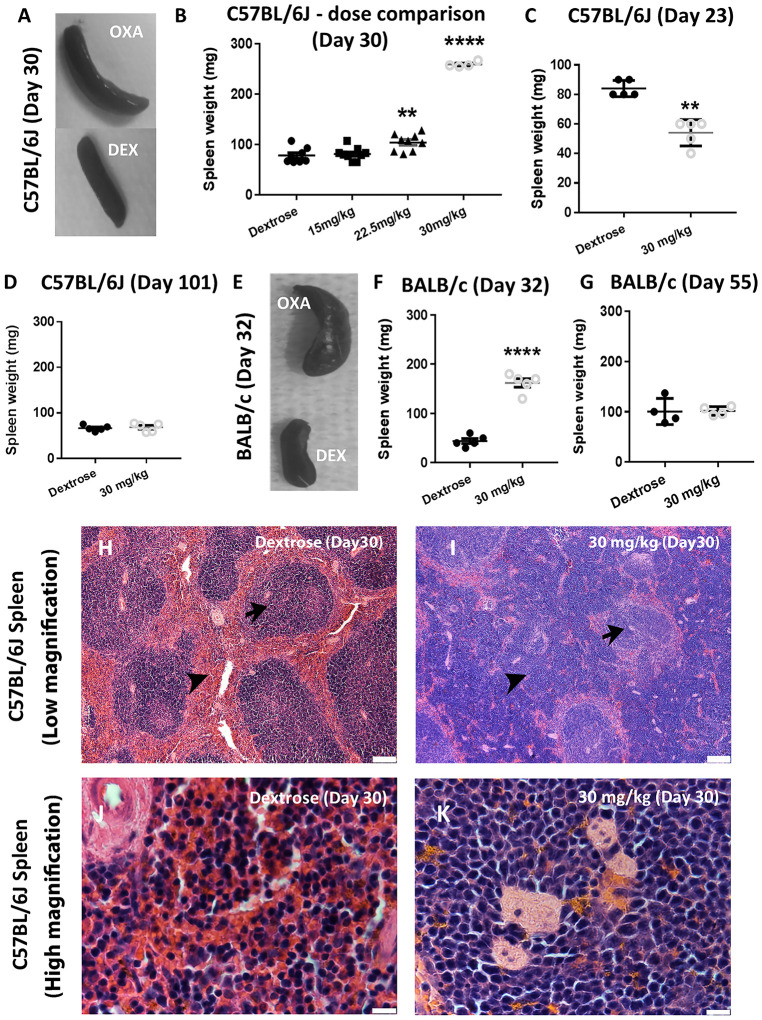
Oxaliplatin induces dose-dependent splenomegaly.(A) C57BL/6J mice spleens from dextrose treated and oxaliplatin 30 mg/kg treated mice. (B) Weight of C57BL/6J mice spleens treated with escalating oxaliplatin dosage regimens demonstrated significant spleen weight increase at ‘Day 30’ (Mean ± SEM; Dextrose n = 8, 15 mg/kg n = 9, 22.5 mg/kg n = 9, 30 mg/kg n = 4; p<0.01 = **, p<0.0001 = ****), (C) In mice treated with 30 mg/kg regimen the spleen weight was reduced at ‘Day-23’ (Mean ± SEM; Dextrose n = 5, 30 mg/kg n = 5; p<0.01 = **), (D) At 3 months (101 days) C57BL/6J spleen weight had returned to normal (Mean ± SEM; Dextrose n = 5, 30 mg/kg n = 5), (E-F) BALB/c mice treated with chronic oxaliplatin regimen demonstrated significant spleen weight increase at ‘Day-32’ (Mean ± SEM; Dextrose n = 5, 30 mg/kg n = 5; p<0.0001 = ****), (G) At 55 days BALB/c spleen weight had returned to normal (Mean ± SEM; Dextrose n = 4, 30 mg/kg n = 4). BALB/c strain data are related to (Fig 3E-3G) only, all other data in this manuscript relate to C57BL/6J mice. Histology of the spleen from (H, J) Dextrose treated control C57BL/6J mice and (I, K) C57BL/6J mice treated with 30 mg/kg dosage at ‘Day-30’; arrowheads—red pulp, arrows–white pulp; J,K = red pulp region. (H, I scale bar = 100μm; J, K scale bar = 10μm).